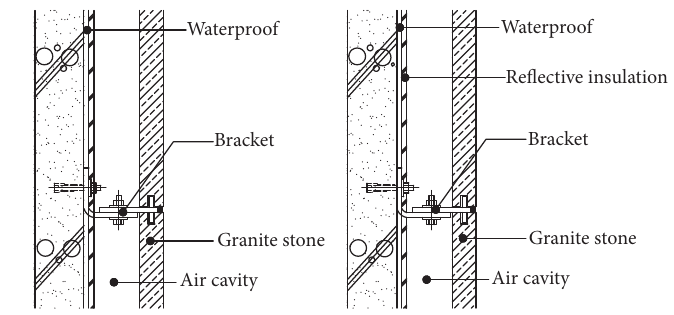
Figure 2: Wall section detail.